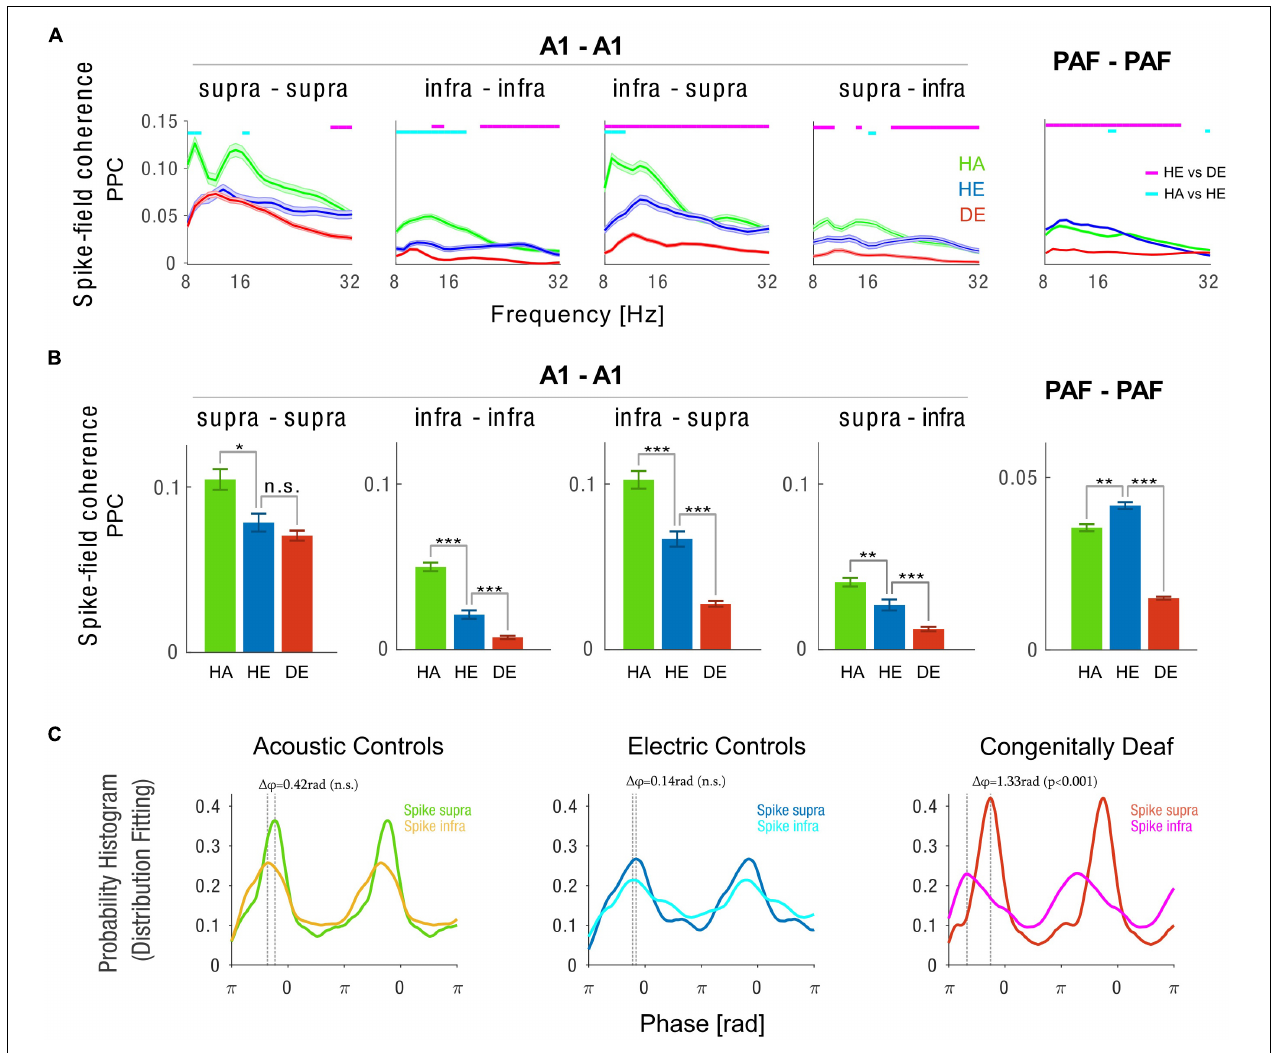
FIGURE 4 | Intra-areal spike-field coherence in A1 and PAF. (A) Spike-field coherence spectra computed with pairwise phase consistency (PPC) method for A1 supragranular spikes–A1 supragranular LFPs (first column), A1 infragranular spikes–A1 infragranular LFPs (second column), A1 infragranular spikes–A1 supragranular LFPs (third column), A1 supragranular spikes–A1 infragranular LFPs (fourth column), and PAF spikes–PAF LFPs (fifth column). Shaded areas show the standard error of the mean. Statistical pairwise comparisons are shown for electric control vs. deaf (magenta line above the graph) and animals with intact cochleae vs. acutely deafened cochleae (cyan line above the graph) using the two-tailed Wilcoxon rank-sum test (false discovery rate corrected, p < 0.001). (B) Bar plots of 10 Hz alpha spike-field coherence are plotted in the same order as in panel (A) . HA (green) Acoustic Controls, HE (blue) Electric Controls, DE (red) Congenitally Deaf Cats. n.s. not significant, * p < 0.05, ** p < 0.01, *** p < 0.001, t -test statistics. (C) Probability histogram using fitting distribution showing phase preference from PPC phase distribution for the three animal groups, each for A1 supragranular spikes–A1 supragranular LFPs and A1 infragranular spikes–A1 supragranular LFPs. The difference between two probability histograms was tested using a permutation test ( n = 1,000). A1 primary auditory cortex, PAF posterior auditory field, LFP local field